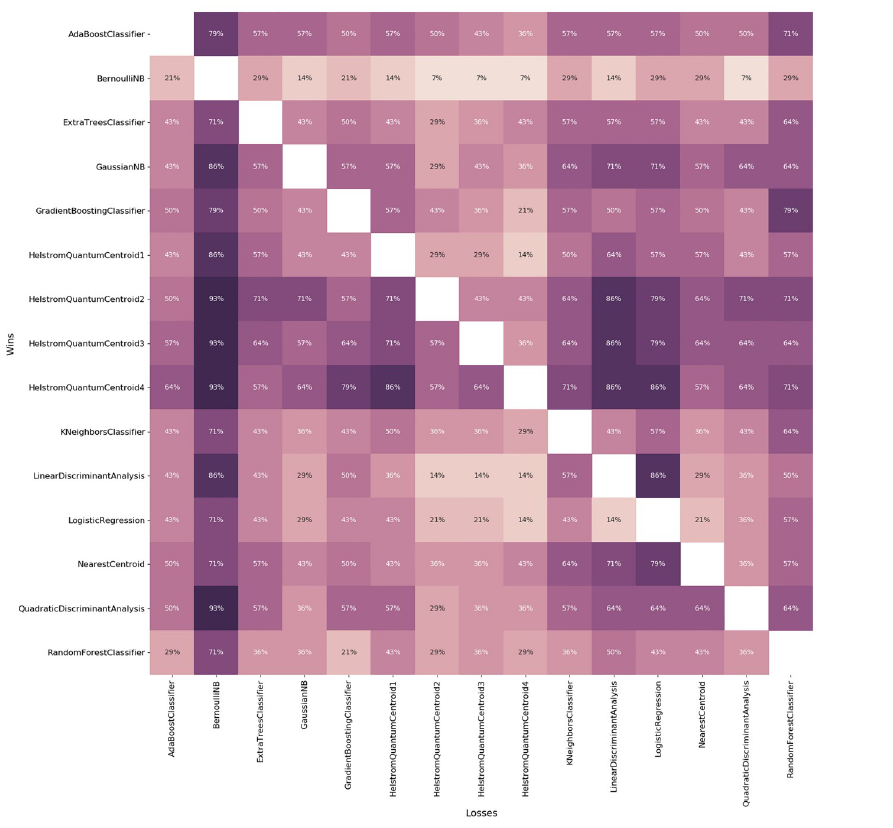
Fig 3. When a classifier A outperforms a classifier B according to the Balanced Accuracy.